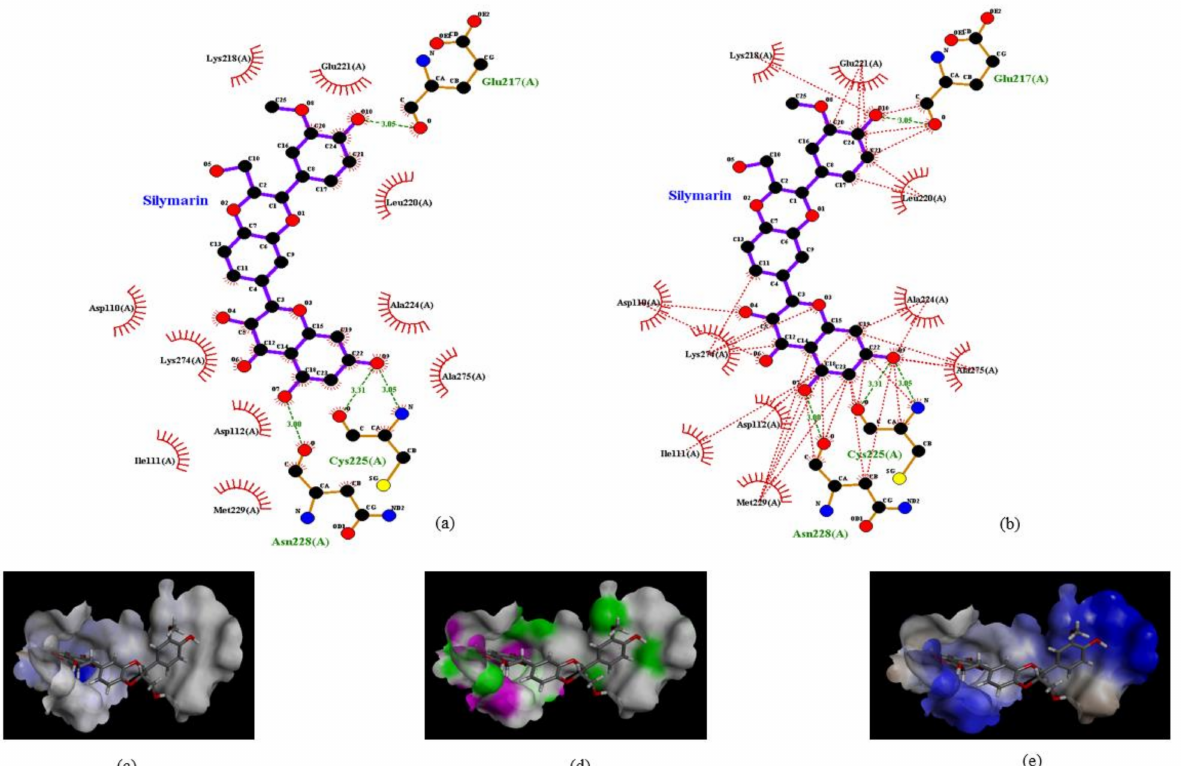
Figure 2. Interaction of silymarin with amino acid residues of homology modeled VP1 (EV-A71, strain 41). ( a ) The amino acids Glu217, Cys225, and Asn228 forming H-bond with silymarin and ( b ) various amino acids of VP1 interacting with silymarin with Van der Waal forces. Interactions were determined using Ligplot software ( c ). Aromatic ( d ) hydrogen (pink: donor; green: acceptor) and ( e ) hydrophobic interactions determined by Discovery studio software.